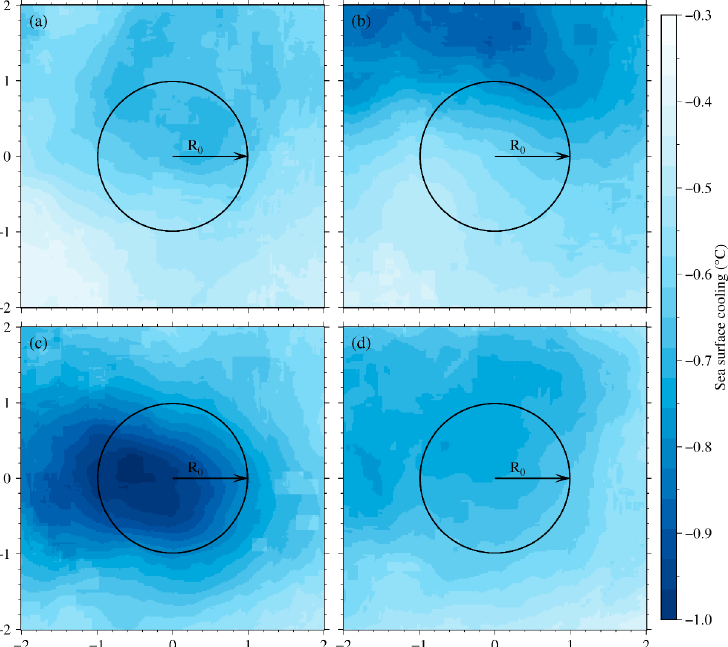
Figure 5. Typhoon-induced SST cooling around eddies located to the ( a , b ) left and ( c , d ) right of typhoon for ( a , c ) CEs and ( b , d ) AEs. All eddies and the surrounding region are interpolated into the same size where the black circle represents the boundary of the eddy, with radius (R 0 ) equal to 110 km, consistent with the average radius of all eddies in the South China Sea between 1995 and 2018.